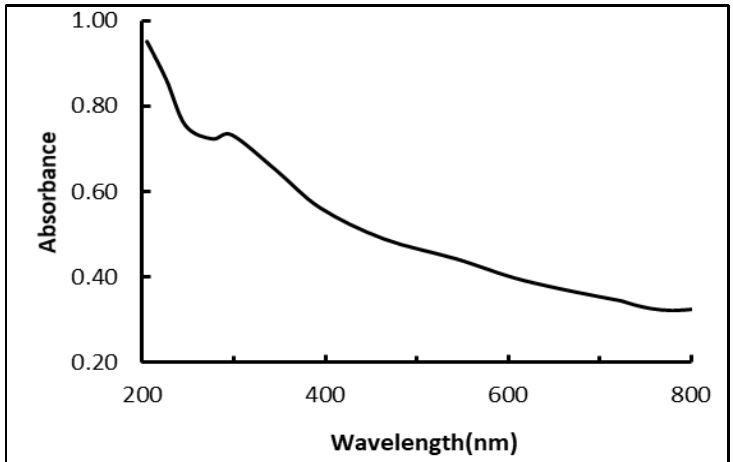
Figure 5: UV-VIS-NIR spectrum typical for Cr2O3 thin film prepared by SP technique.